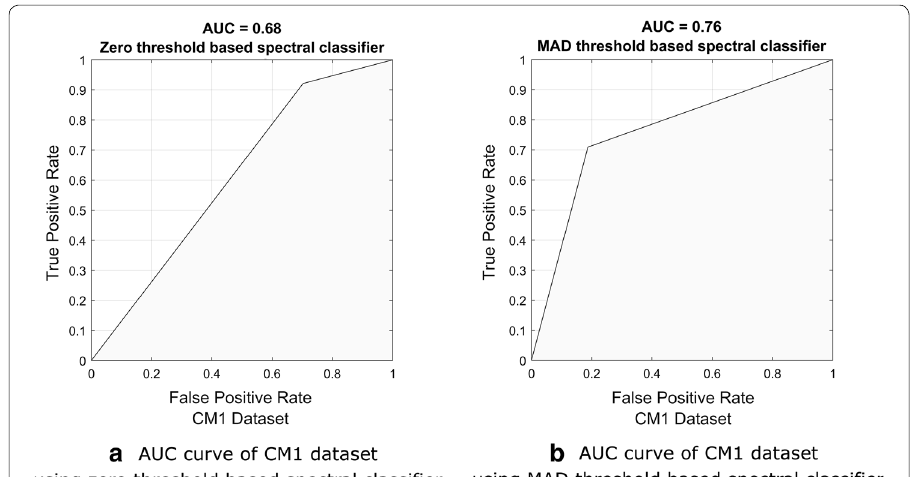
Fig. 4 AUC curve of CM1 dataset. a , b illustrate the AUC curves of CM1 dataset using the zero threshold based spectral classifier and MAD threshold based spectral classifier, respectively. The AUC is the area under the ROC that is constructed using the true positive rate (TPR) or recall across the false positive rate (FPR), which are computed by Eqs. 18 and 20,